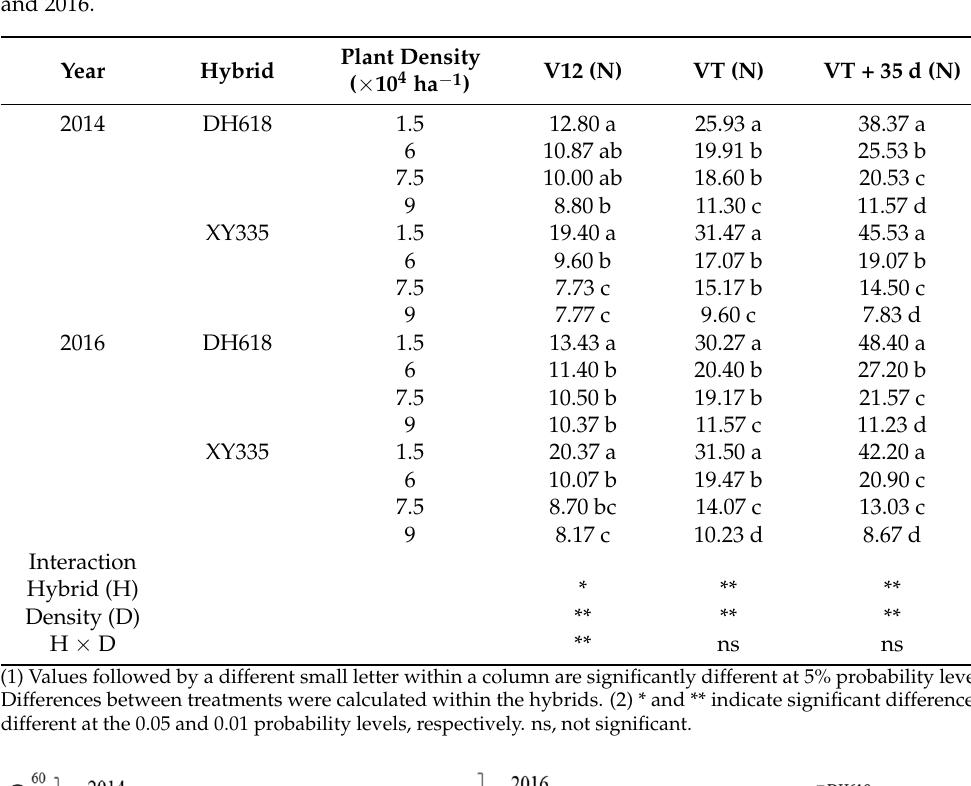
Table 1. Field maximum bending strength of DH618 and XY335 at different growth stages in 2014 and 2016.